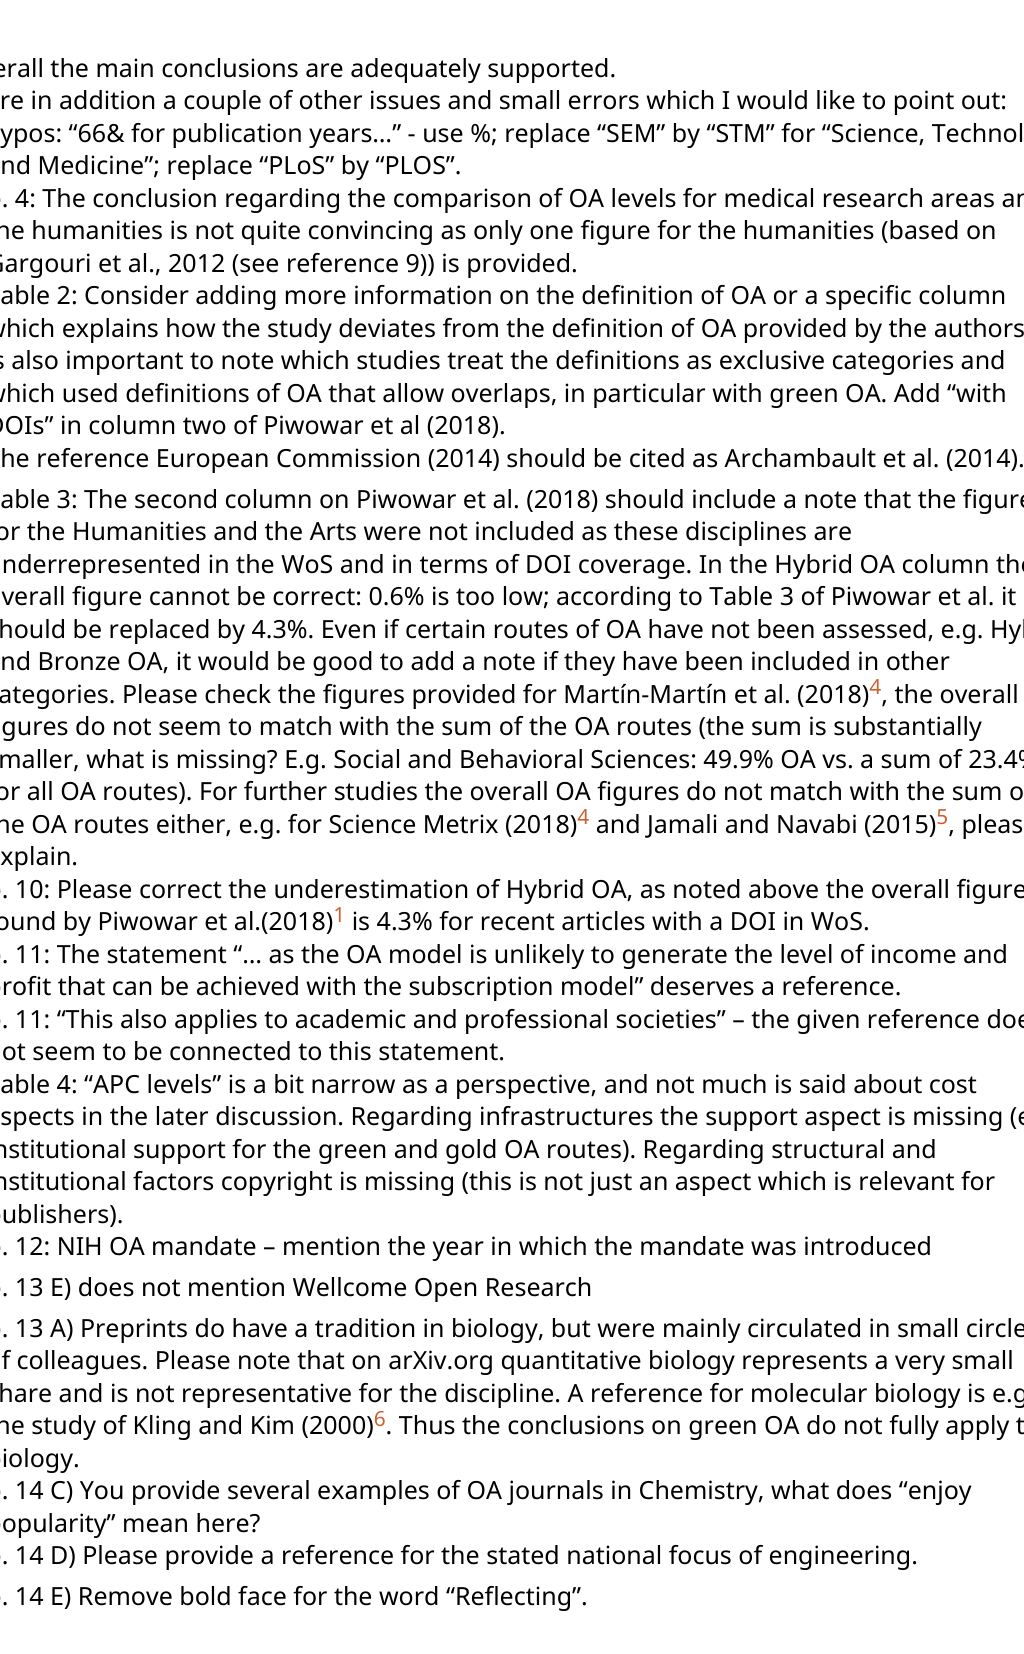
Table 2: Consider adding more information on the definition of OA or a specific column